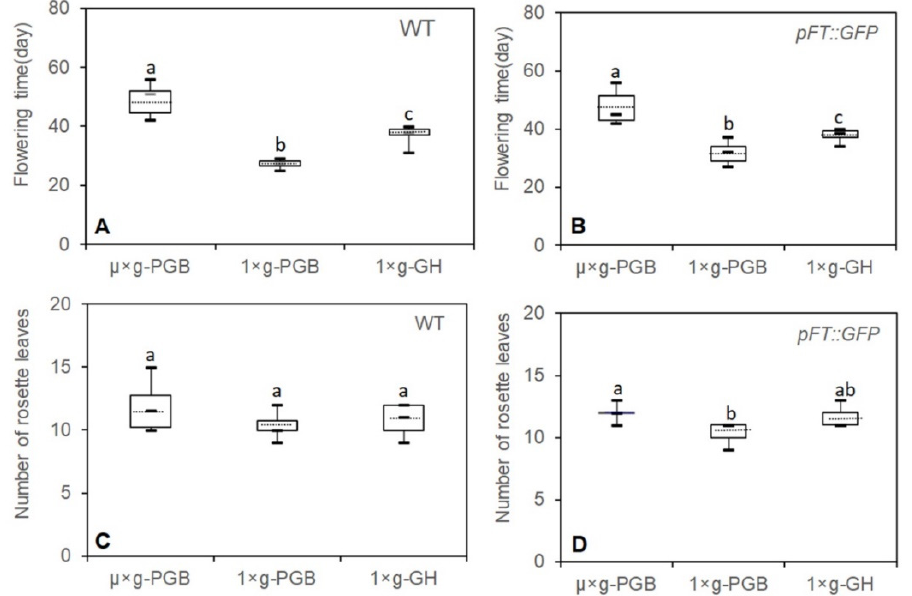
Figure 4. Flowering time of plants grown under long-day (LD) conditions in space and on ground was recorded. ( A , B ) Flowering time of Arabidopsis wild-type (WT) and transgenic plants ( pFT::GFP ) grown in culture chambers under microgravity (µ× g ) in the space plant culture boxes (µ× g -PCB) and under the normal gravity (1× g ) in the ground PCB (1× g -PCB) or in GH (1× g -GH) was recorded. ( C , D ) Total leaf number was counted when floral buds became visible. Each box plot shows 1.5 × interquartile range of the data points, third quartile, median and first quartile value. Dotted lines show mean value ( n = 6 – 10). Different letters indicate statistical significance by Student’s t -test ( p < 0.01).